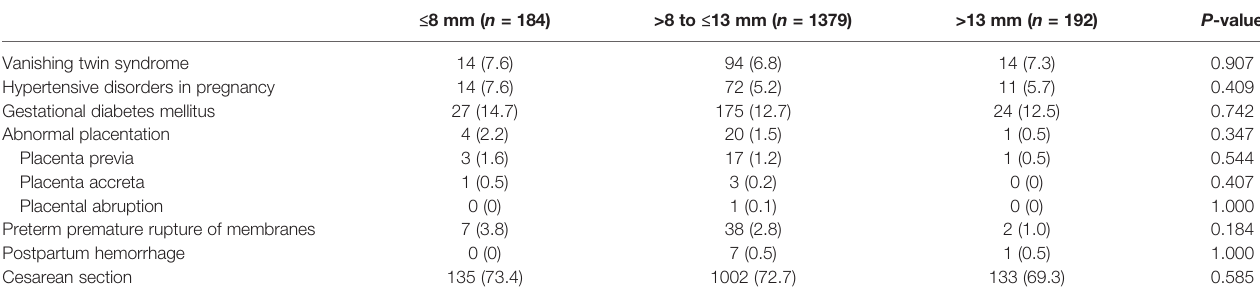
TABLE 2 | Obstetric outcomes grouped by endometrial